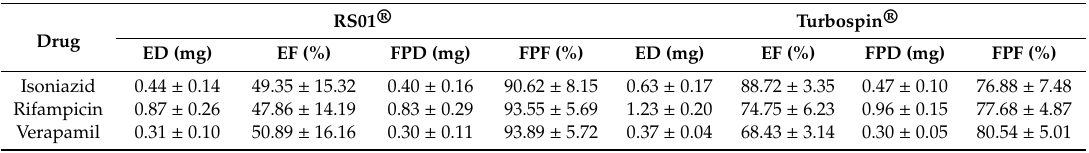
Table 2. Emitted Dose (ED), Emitted Fraction (EF), Fine Particle Dose (FPD) and Fine Particle Fraction (FPF) obtained upon aerosolization with the two devices, referred to the single drugs ( n = 3 ± standard deviation).